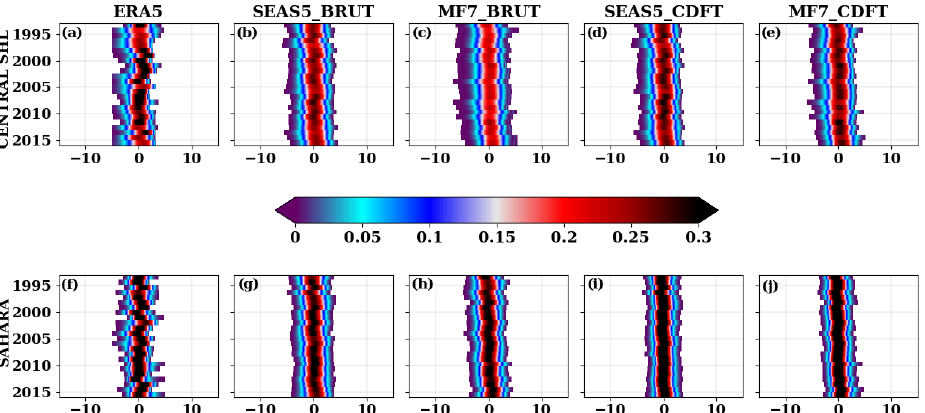
Figure 8. Same as Fig. 7 but for the yearly anomalies of temperature. The anomalies are computed by removing the daily climatology temperature for each